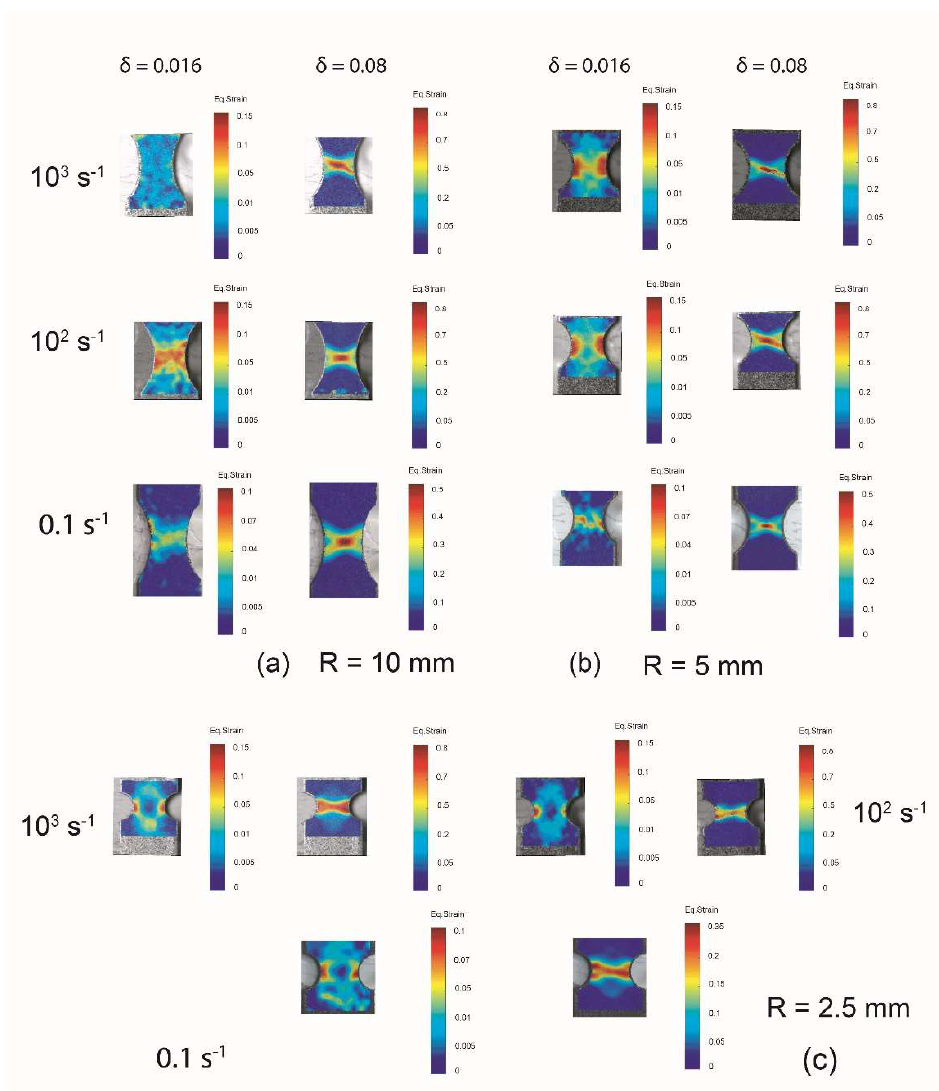
Figure 6. Equivalent strains in specimens with notch radii of ( a ) 10, ( b ) 5, and ( c ) 2.5 mm under tension at strain rates of 10 3 , 10 2 , and 0.1 s −1 at the temperature of 673 K.